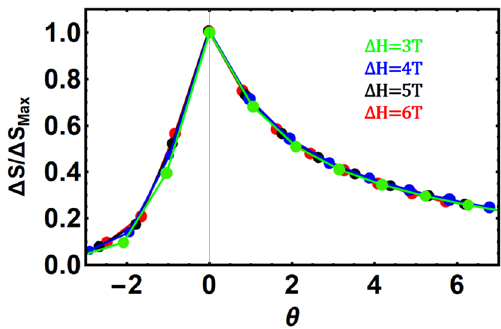
Figure 15. The universal curve for YFe 3